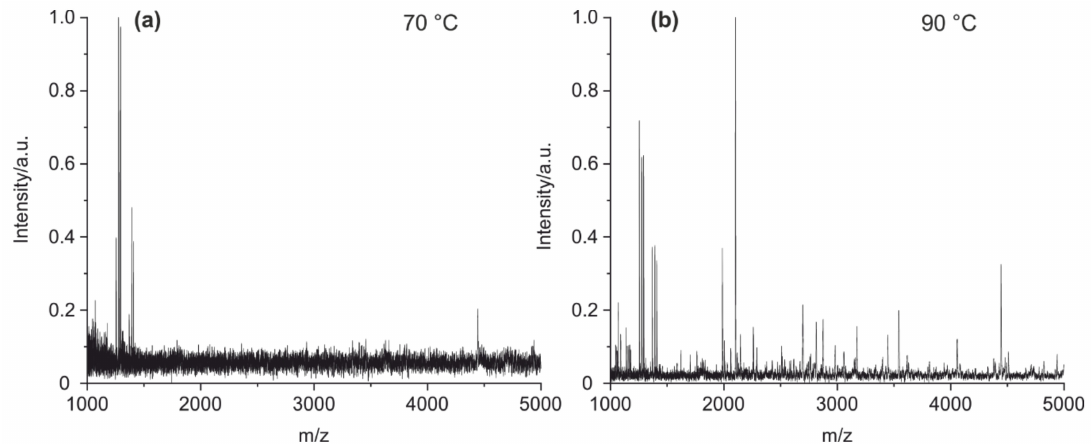
Figure 4. MALDI-TOF MS spectra of ( a ) mouse IgG1 cleaved at 70 ◦ C and ( b ) mouse IgG1 cleaved at 90 ◦ C. The di ff erence is obvious. It can be suspected that some antibodies are not su ffi ciently denatured at 70 ◦